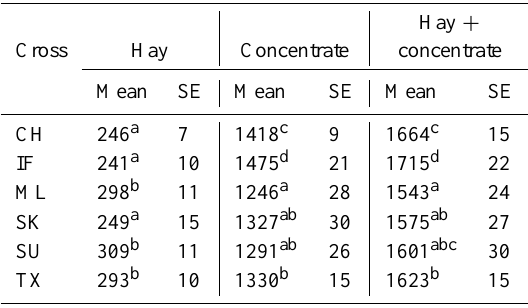
Table 2. Effect of cross on daily feed intake (g) of hay, concentrate and sum of both during the fattening period of lambs.